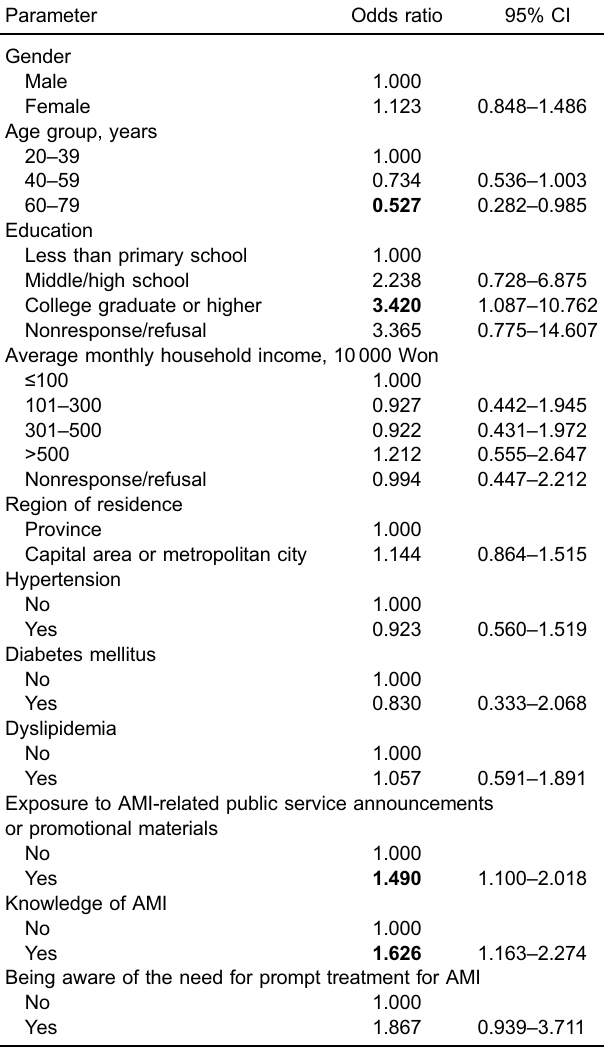
Table 4. Multivariable logistic regression analysis a : factors related to excellent knowledge